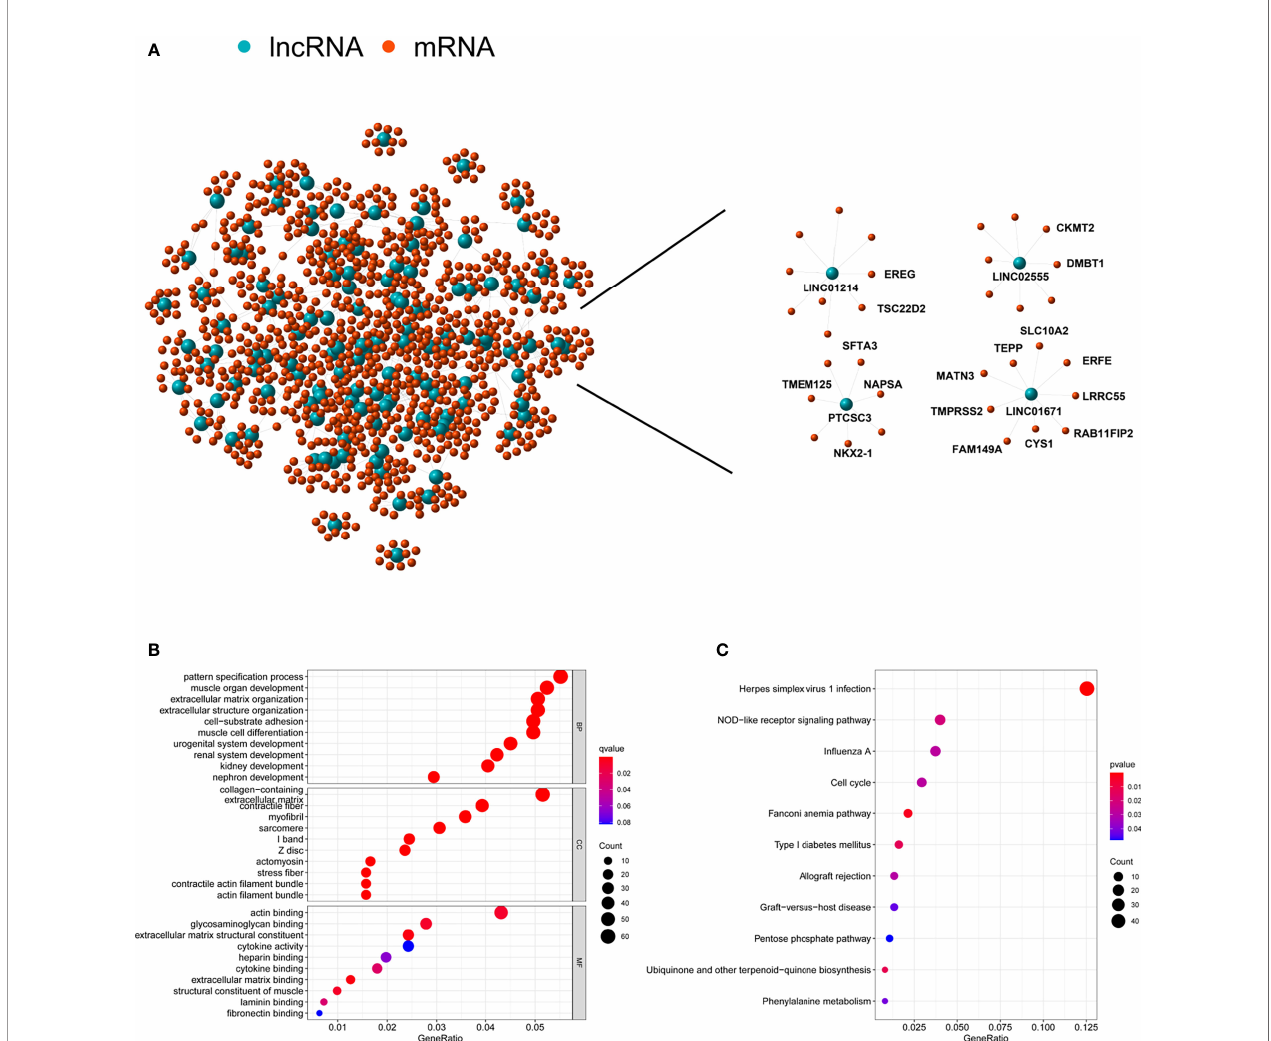
FIGURE 5 | Functional annotation of lncRNA related to genomic instability and construction of lncRNA-mRNA co-expression network. (A) Co-expression network of genomic instability-associated lncRNAs and mRNAs. LncRNAs were represented by the blue circles, and mRNAs were represented by the red circles. (B) Gene Ontology (GO) enrichment analysis for mRNAs co-expressed lncRNAs. (C) Kyoto Encyclopedia of Genes and Genomes (KEGG) pathway analysis for mRNAs co-expressed